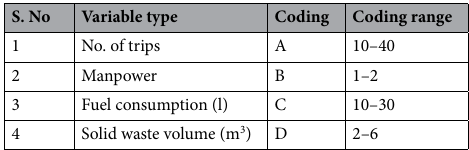
Table 1. Process parameters used in the design of